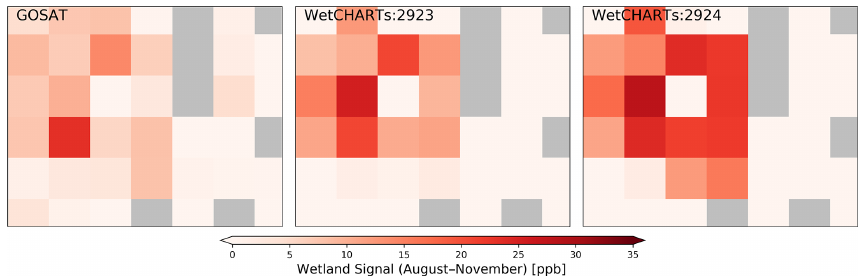
Figure 11. The average wetland signal for August–November between 2009 and 2017 over the Congo region. The wetland signal is defined as the difference between the detrended GOSAT or WetCHARTs model simulations and the simulation with no wetland emissions. Two WetCHARTs ensemble members are shown (2923 and 2924) for illustration, but all ensemble members exhibit similar behaviour.